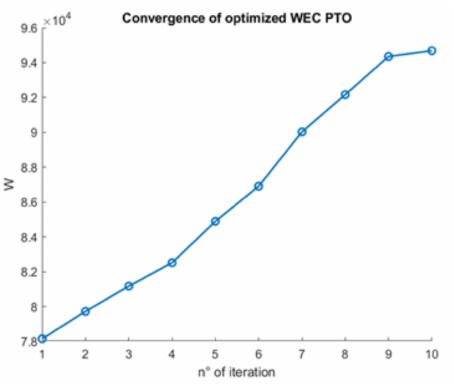
Figure 10. WEC’s PTO simulink block.